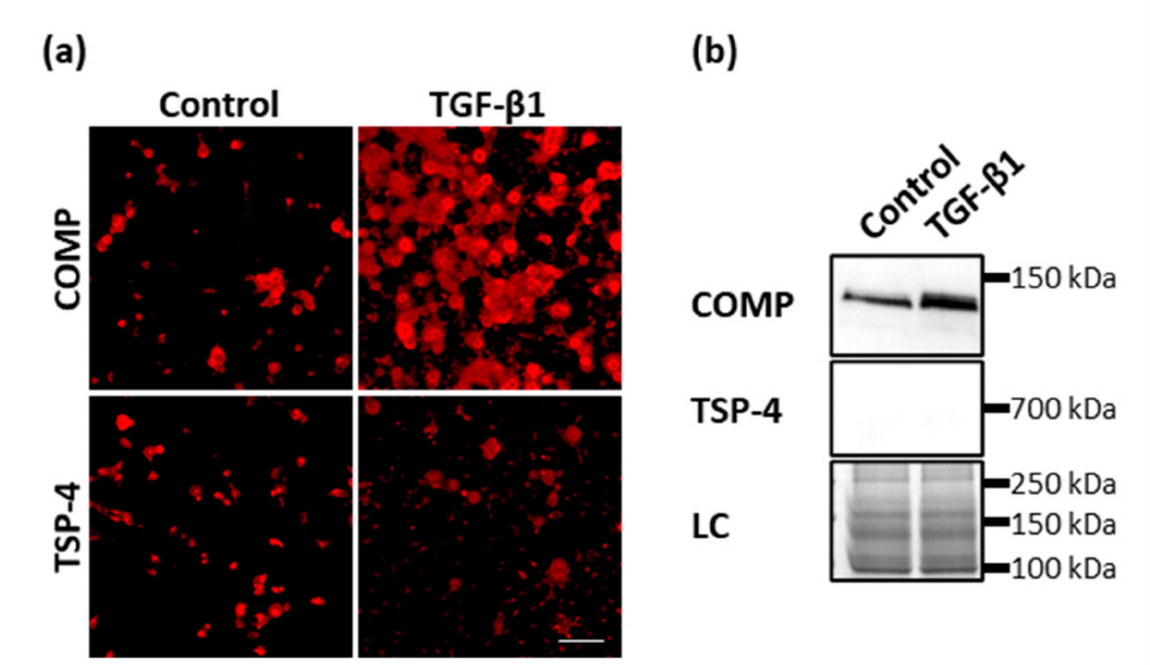
Figure A2. The effect of TGF- β 1 on COMP and TSP-4 synthesis and deposition. Chondrocytes were stimulated with TGF- β 1 (0.5 ng/mL) for seven days. COMP and TSP-4 were detected with specific antibodies. ( a ) Immunofluorescence staining of COMP and TSP-4 at day 10. ( b ) Immunoblot assays of chondrocyte supernatants at day 10. Roti ® blue staining of proteins was used as a loading control (LC). ( n = 3 per group); unstimulated cells were used as a control; scale bar = 100 µ